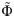
Visual representation of the CoDiNA method for a 3-network comparison: Categories definition.2a represents where the α links lie in the 3D space. 2b and 2c represent the locations of β and γ links, respectively. The complete set of Φ and Φ˜ positions is shown in 2d.